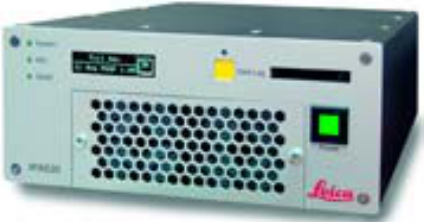
Figure 2. Leica IPAS20 (source: Leica)